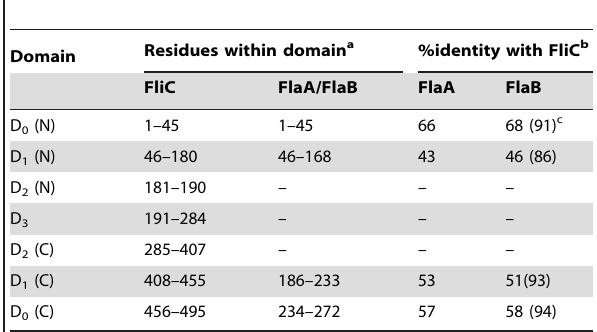
Table 2. Alignment of S. typhimurium FliC with S. oneidensis FlaA and FlaB.